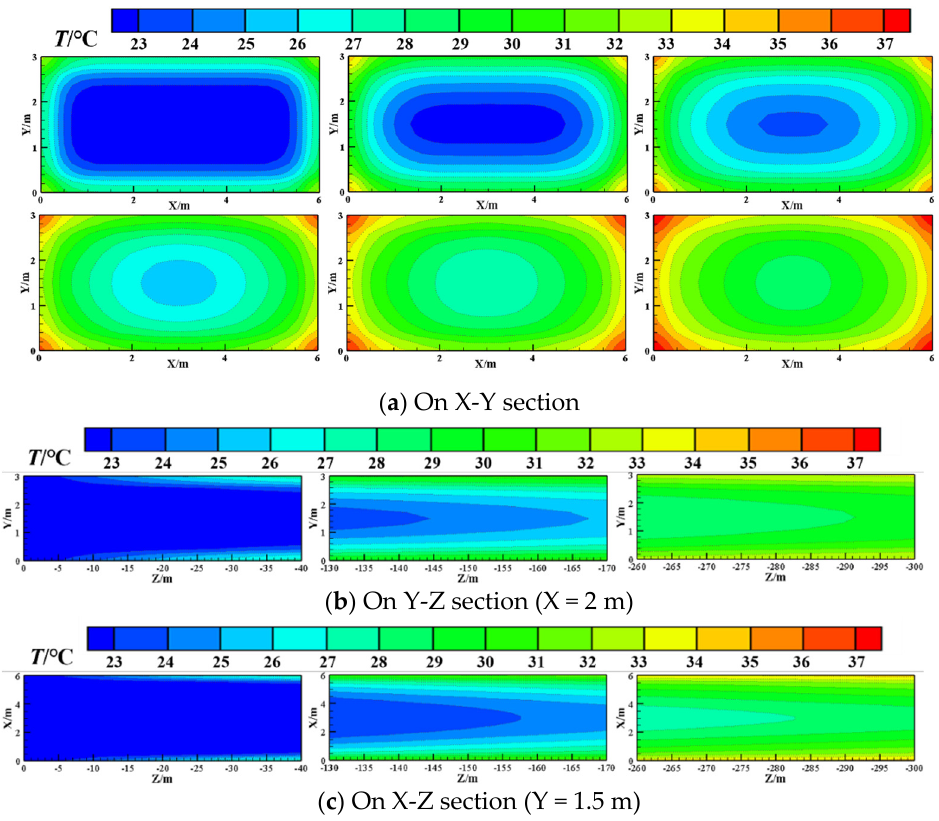
Figure 6. Airflow temperature distribution in different sections of the working face before cooling.